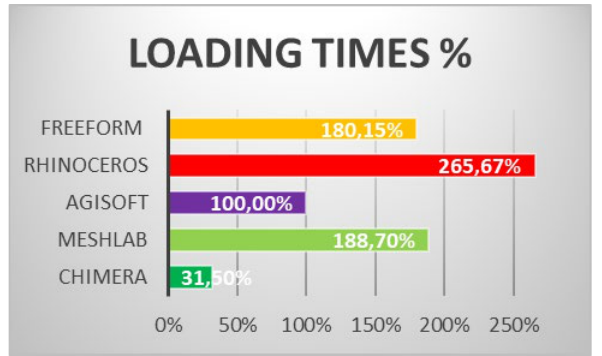
Figure 7 – Loading times in percent, setting Agisoft as 100%; lower is